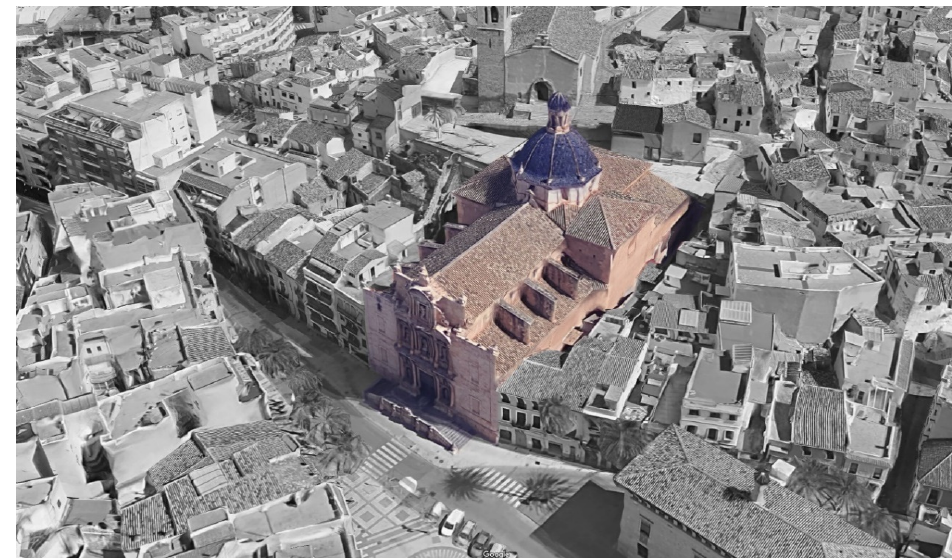
Figure 1. Aerial view of the building (Source: Google & National Geographic Institute of Spain).